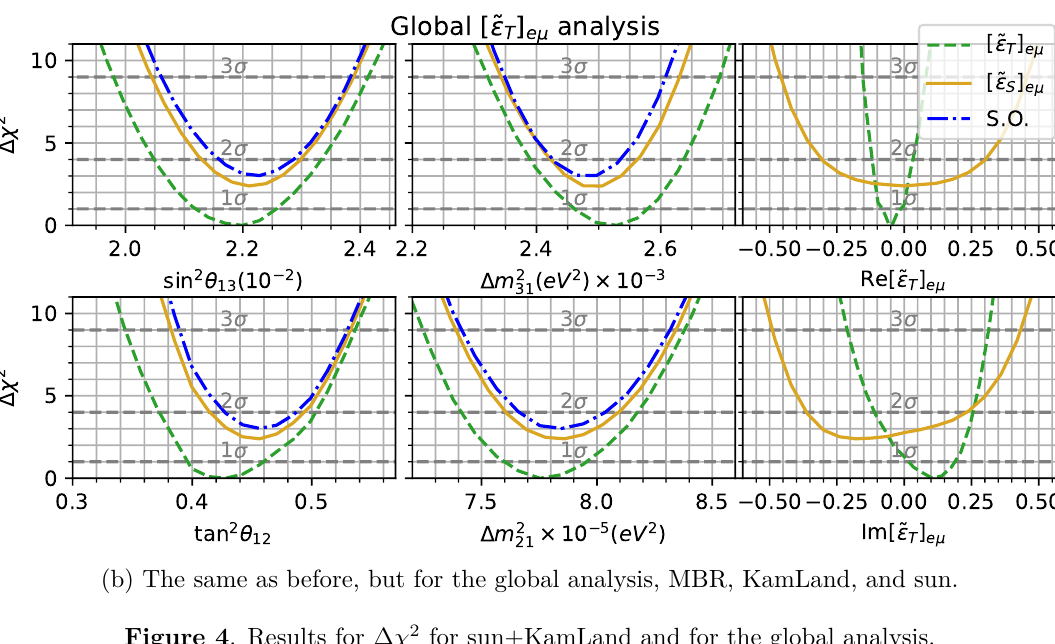
(a) Here we show the ∆ χ 2 as a functions for the sin 2 θ considering KamLand + solar data. The yellow (green) curve shows the tensor (scalar) NSI scenario, and the dashed-dotted blue curve is the standard neutrino oscillation scenario (S.O.).